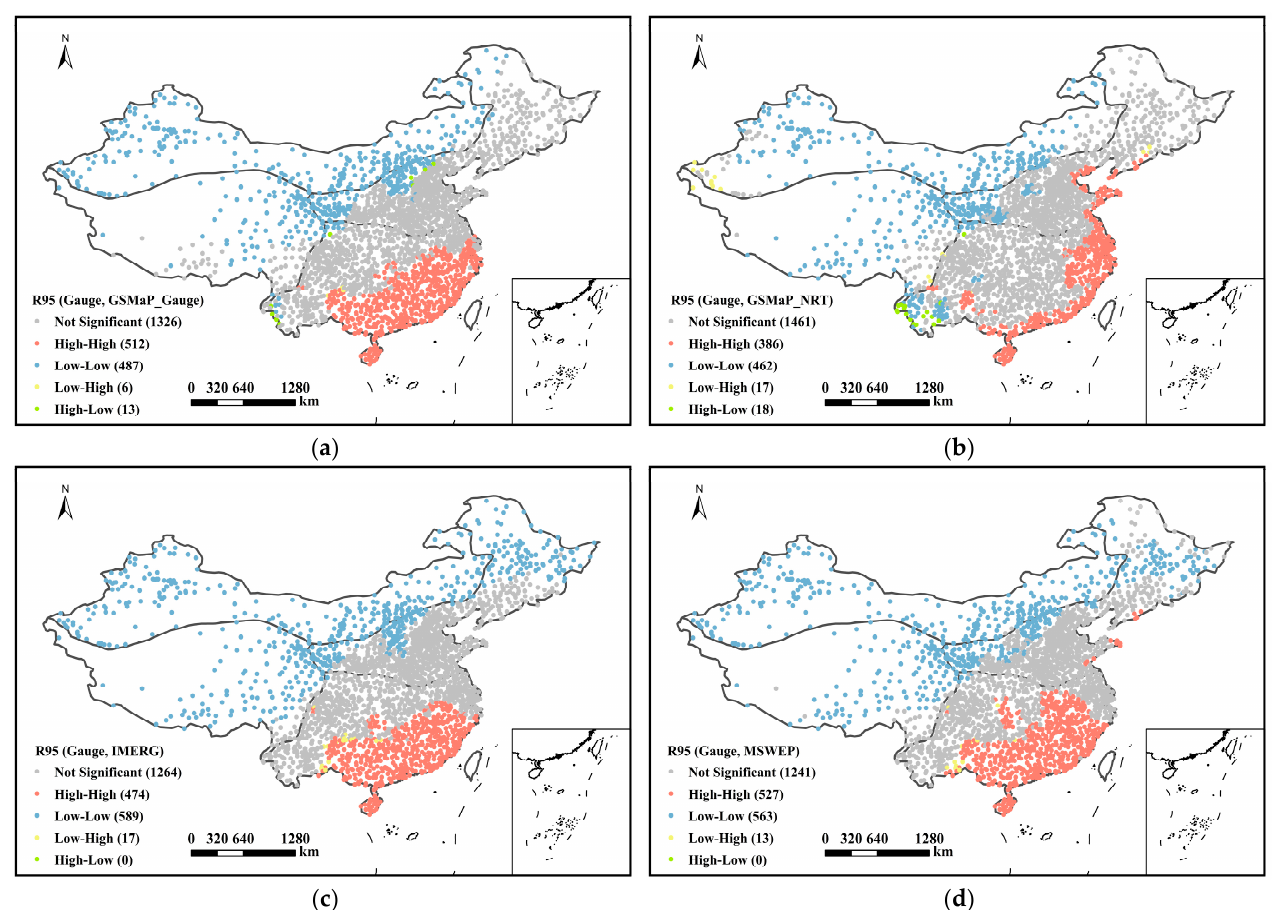
Figure 12. The LISA cluster maps of R95 between the gauge observations and the four SPPs and the number in the bracket represent the corresponding number of gauges: ( a ) GSMaP_Gauge, ( b ) GSMaP_NRT, ( c ) IMERG, and ( d ) MSWEP.